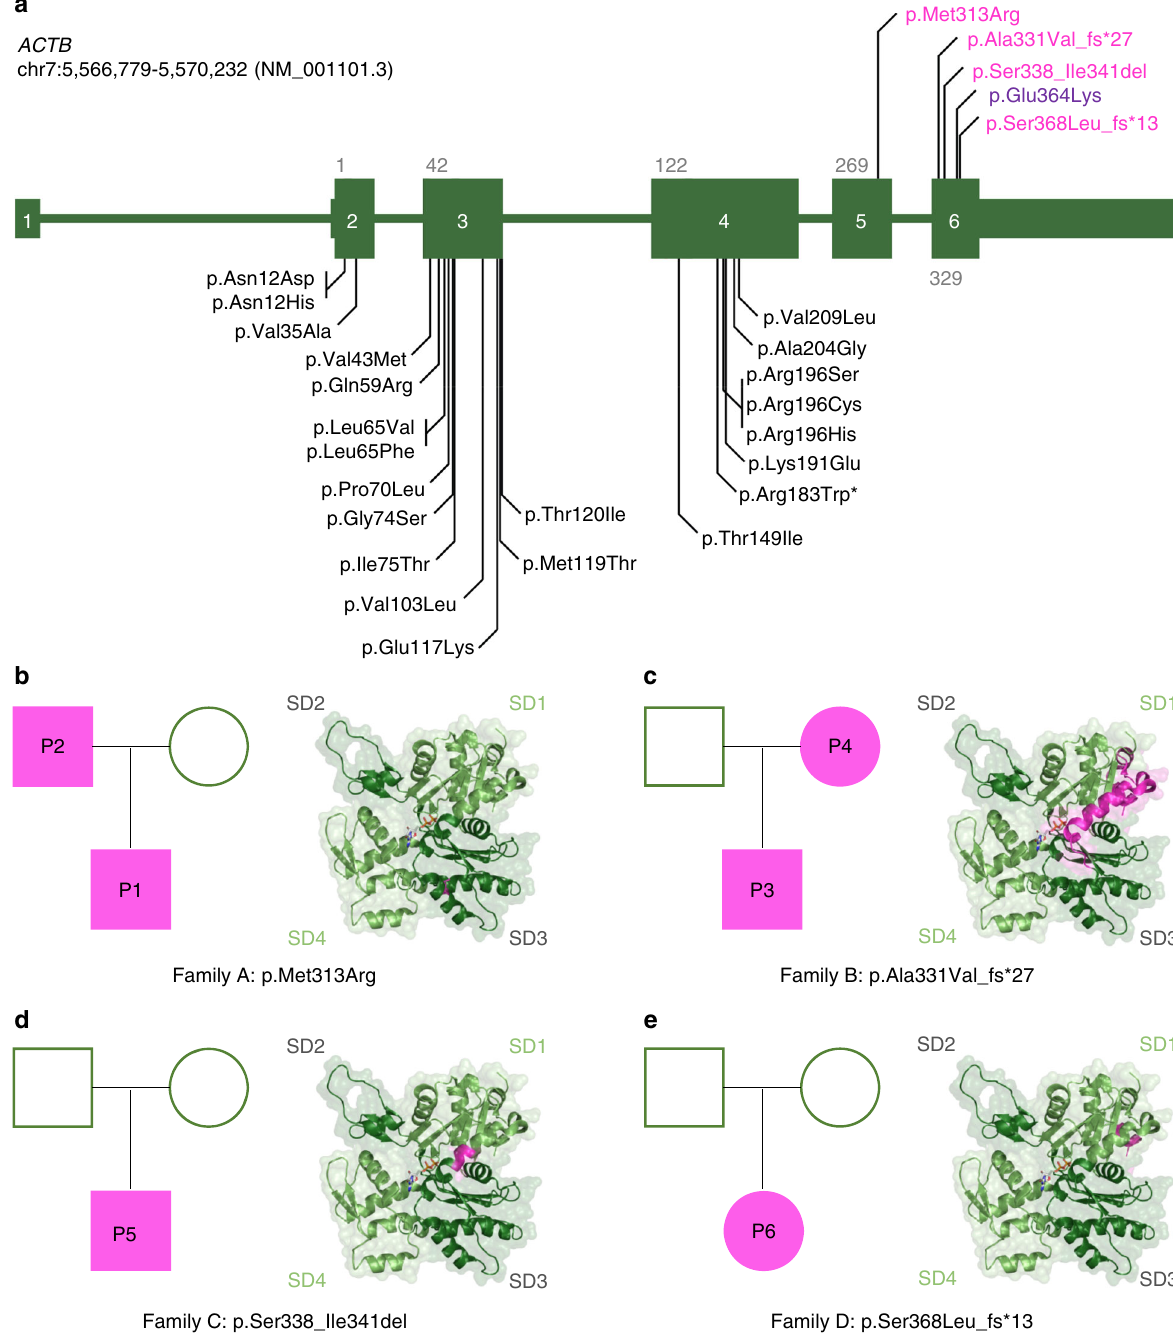
Fig. 1 Overview of ACTB -AST mutations. a Schematic representations of ACTB mutations. ACTB -AST mutations are shown in magenta above the gene model and BWCFF-associated mutations from the literature and from our own patients are given below the gene model; Asterisk (*) indicates a speci fi c variant associated with progressive dystonia 67 . Genomic coordinates refer to the GRCh37/hg19 genome assembly. Exons are numbered and coding exons are indicated by large boxes; b – e Pedigree charts (left) and in silico representations of impacted residues (right) in b Family A (P1 and P2) — ACTB : p. Met313Arg, c Family B (P3 and P4) - ACTB : p.Ala331Val_fs*27, d Family C (P5) — ACTB : p.Ser338_Ile341del and e Family D (P6) — ACTB : p.Ser368Leu_fs*13. For pedigree charts, squares represent males, circles indicate females, magenta-shaded symbols indicate individuals with ACTB -AST and patients are numbered according to the text. For in silico representations, affected amino acid residues are indicated in magenta on the actin protein structure (PDB